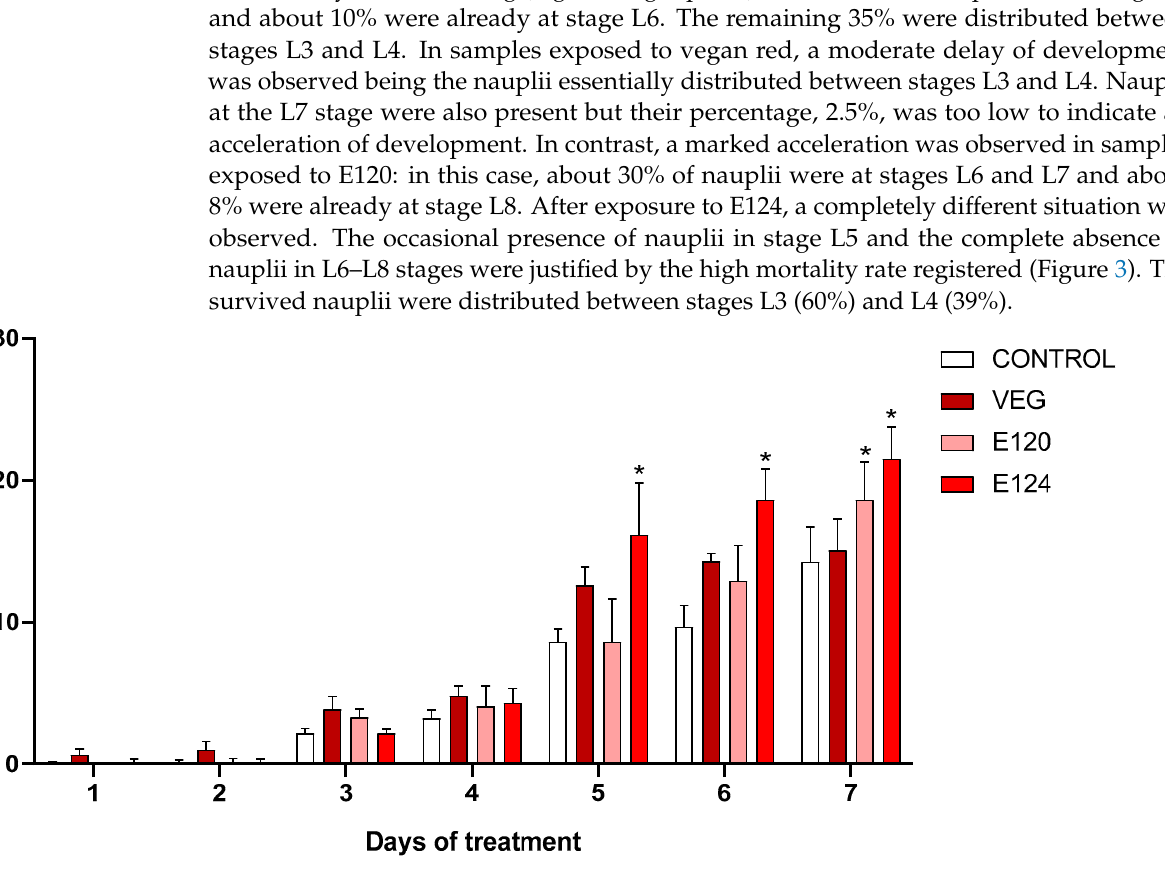
Figure 3. Mortality percentage in Artemia salina nauplii exposed to vegan red VEG, E120, or E124. Notice the significant increase registered for E124 since day 5 and for E120 on day 7. (Data are mean ± SEM; * p < 0.05).